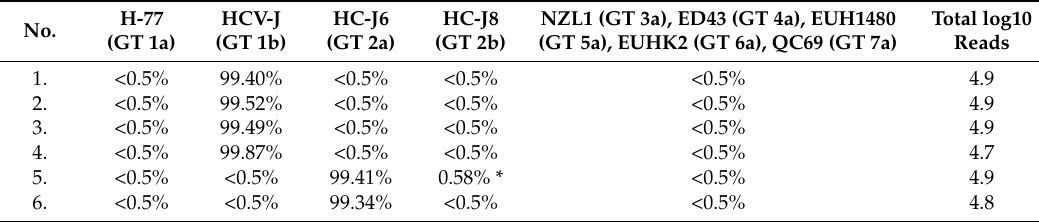
Figure 1. HCV genotypes (GTs) by deep sequencing of HCV NS4 regions. For each sample, only populations that exist at a frequency of >0.005 (red line) were shown by log-scale. No. 5 with the main genotype 2a had minor populations assigned to the different genotype 2b. No. 13 with genotype 2b had minor populations assigned to the different genotype 2a. Table 6. HCV genotypes by deep sequencing of HCV NS4 regions.